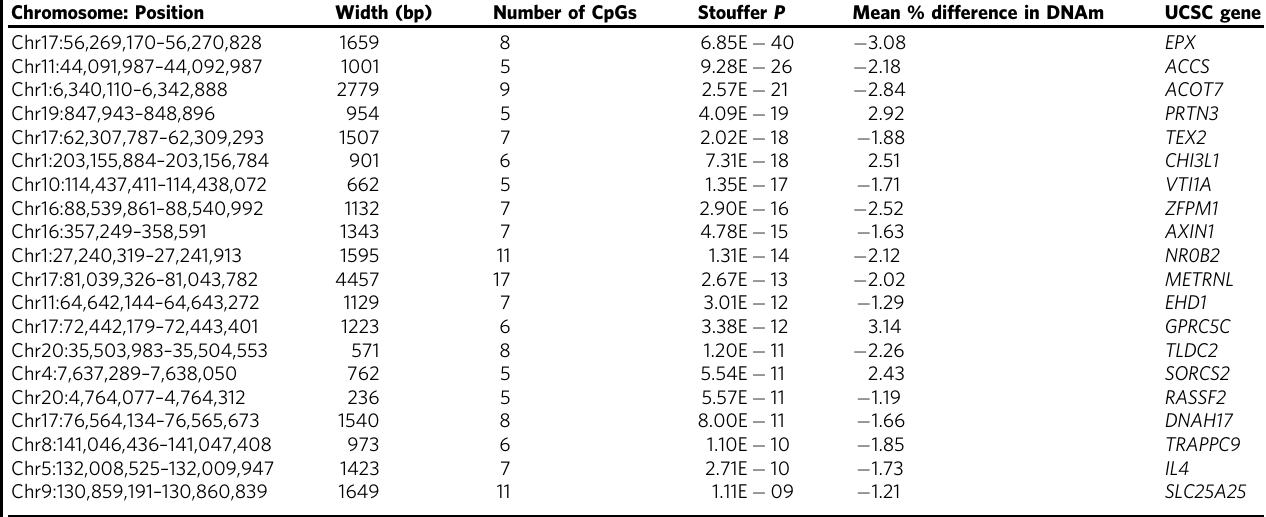
Table 4 Top 20 DMRs associated with log 10 FeNO measurements Chromosome: Position Width (bp) Number of CpGs Stouffer P Mean % difference in DNAm